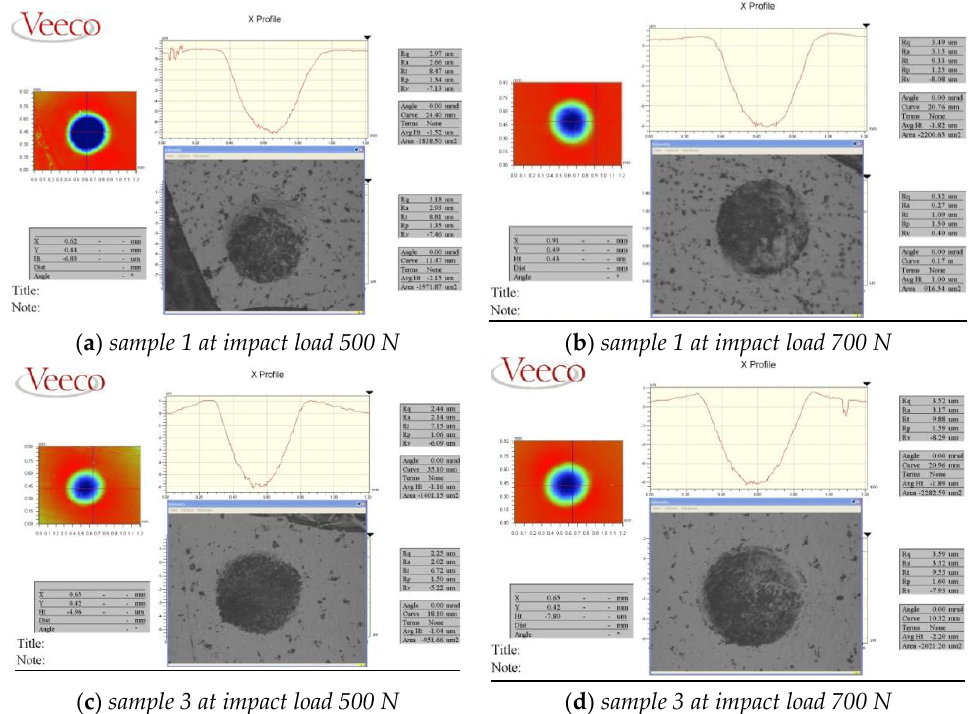
Figure 14. Surface of samples modified with ferroboron and boron-barium ferroalloy. The linear dimensions of the craters (depth and diameter at the base) formed on the surface of modified cast iron samples during impact tests are shown in Figure 15.